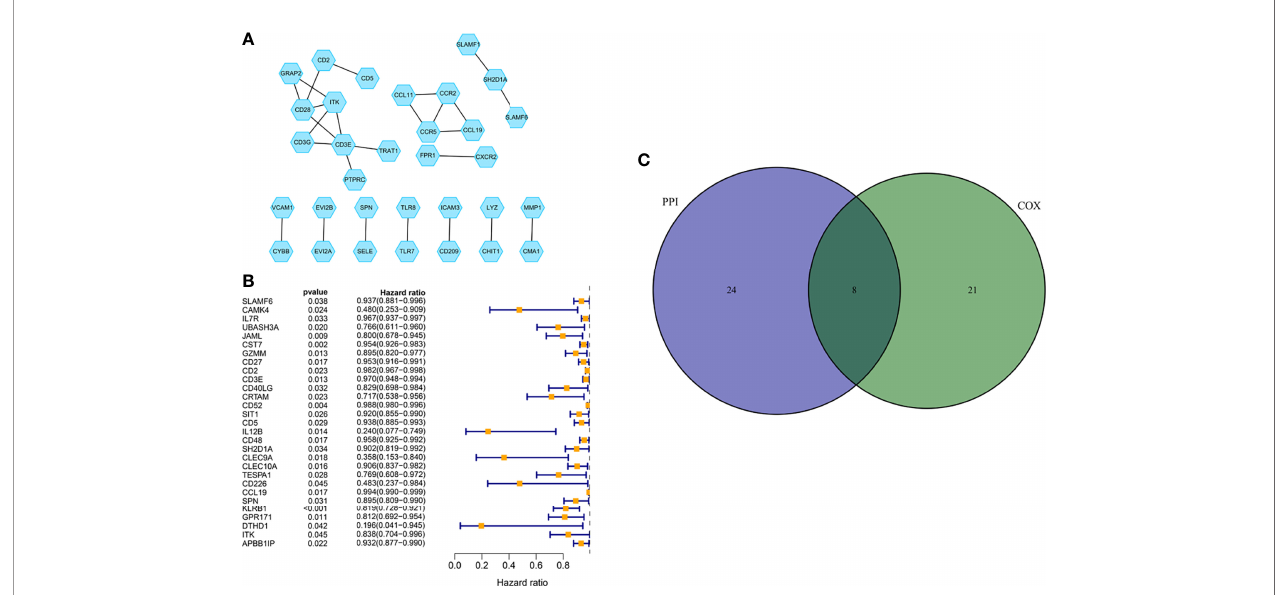
FIGURE 5 | PPI network and COX regression analysis. (A) PPI network was established with a minimum required interaction score of 0.95 and visualized via Cytoscape. (B) Univariate COX regression analysis with the cut-off criteria of p < 0.05. (C) Venn diagram for the presenting of an intersection analysis between top 30 genes from the PPI network and the outcomes from univariate COX regression